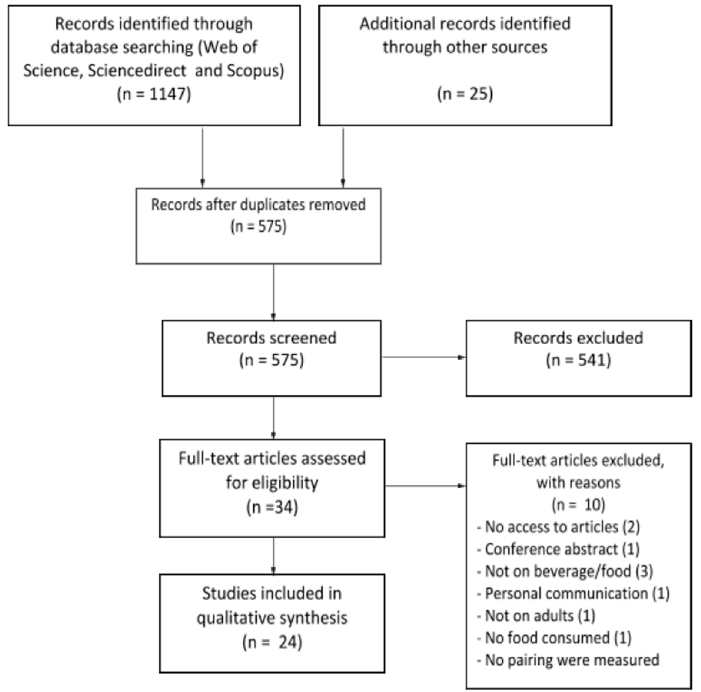
Figure 1. The PRISMA (Preferred Reporting Items for Systematic Reviews and Meta-Analyses) diagram showing the screening process (http://www.prisma-statement.org, accessed on 11 February 2019).